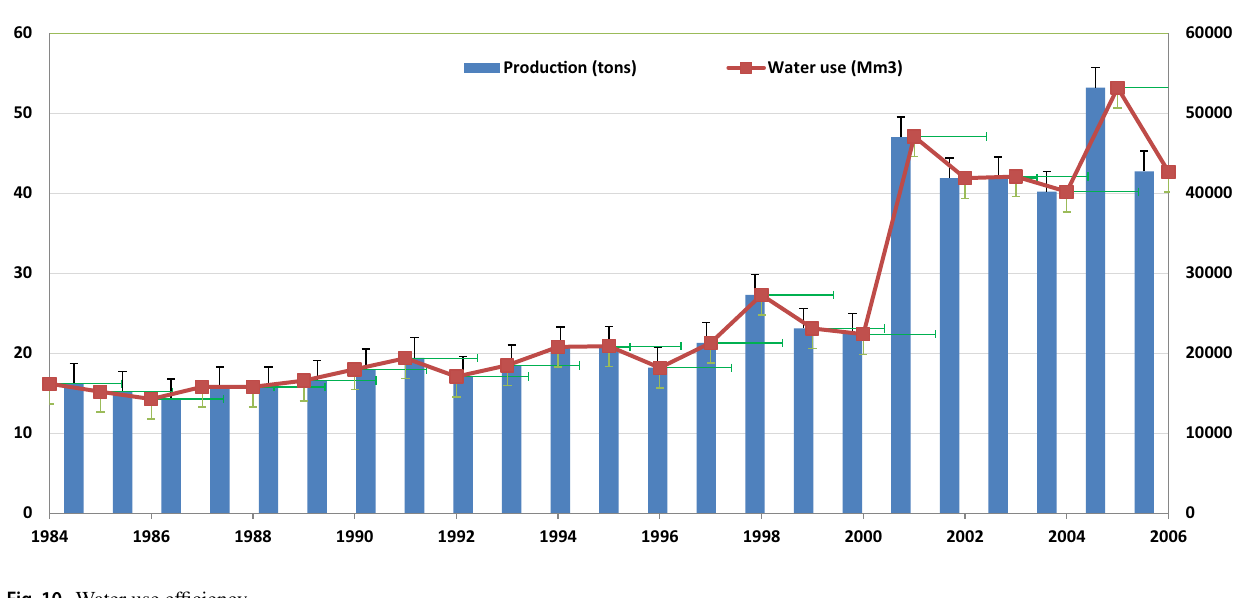
Fig. 10 Water use